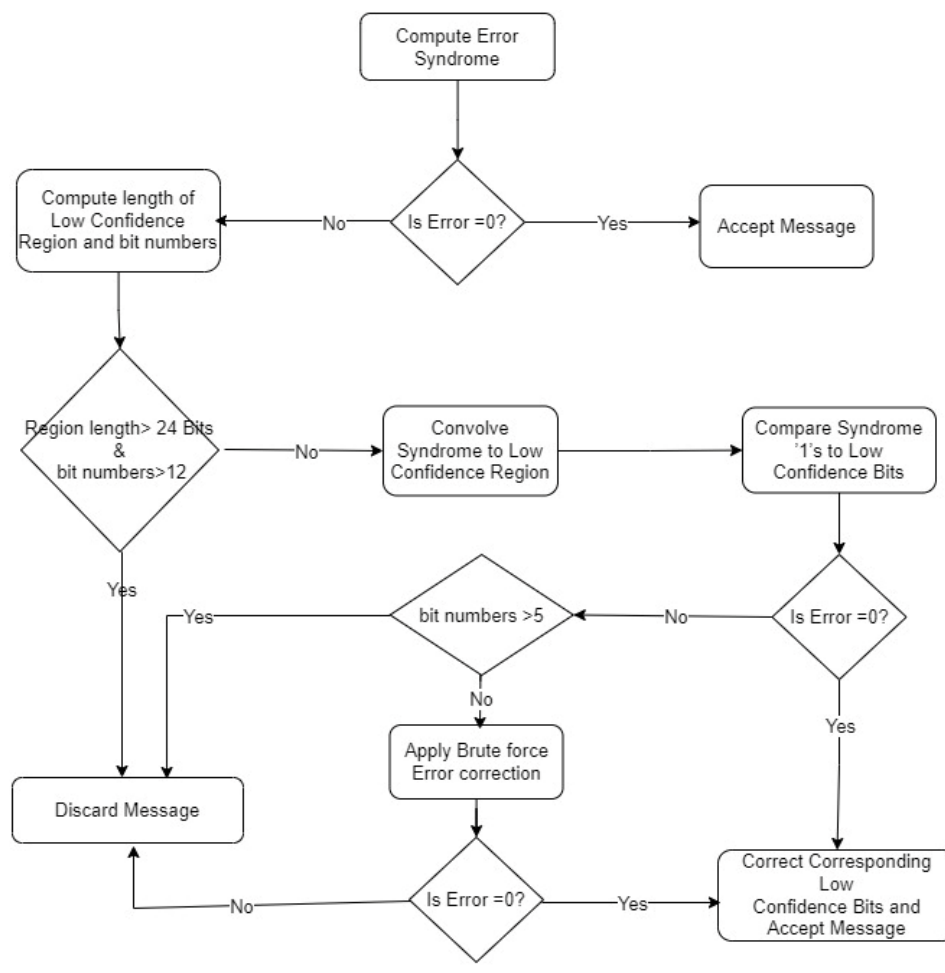
Figure 5. Message Error Correction Algorithm .